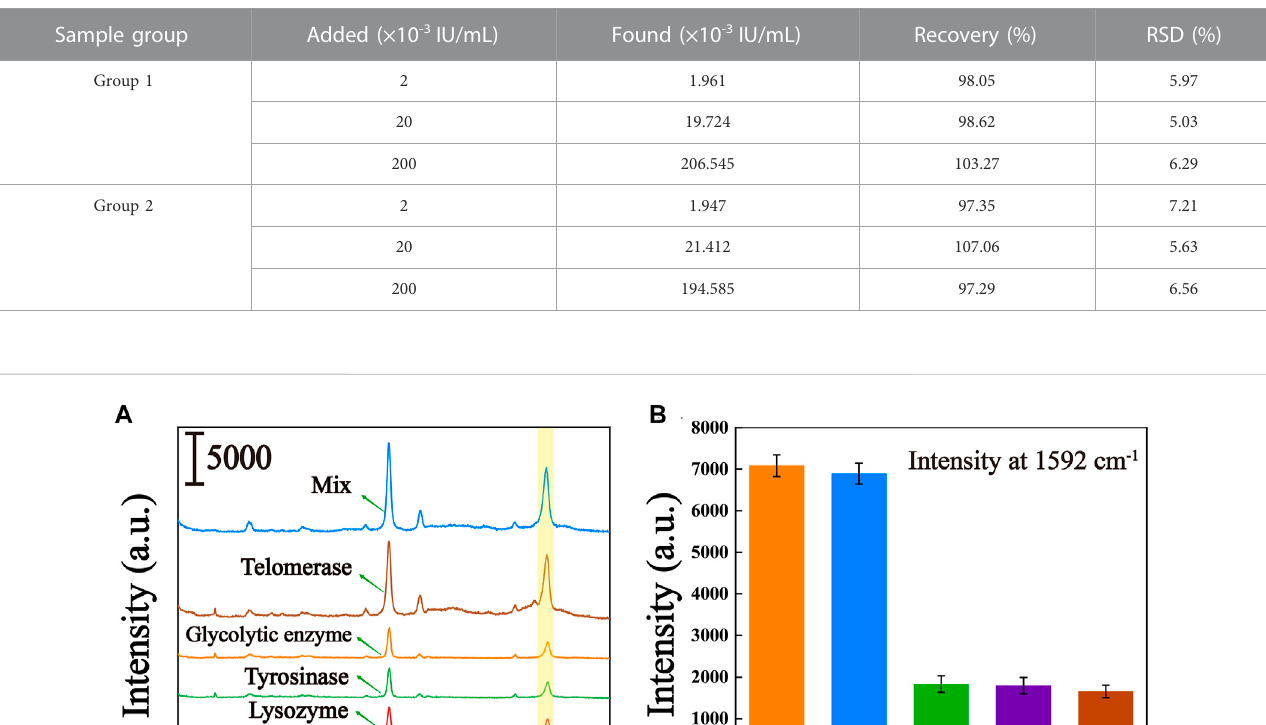
TABLE 2 Recovery of the biosensor based on the proposed strategy.